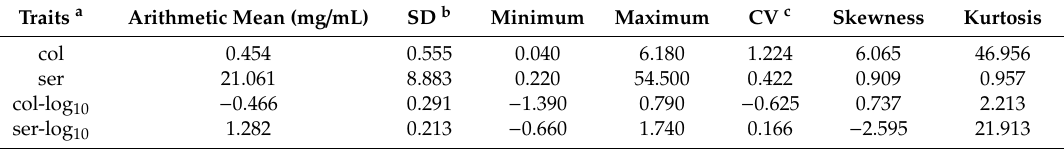
Figure 1. Frequency distribution of the concentration of albumin in colostrum and serum: ( a , b ) show the original colostrum and serum albumin concentrations; ( c , d ) show the log 10 -transformed colostrum and serum albumin concentrations. Table 1. Descriptive statistics for the concentration of albumin in colostrum and serum; n = 572.